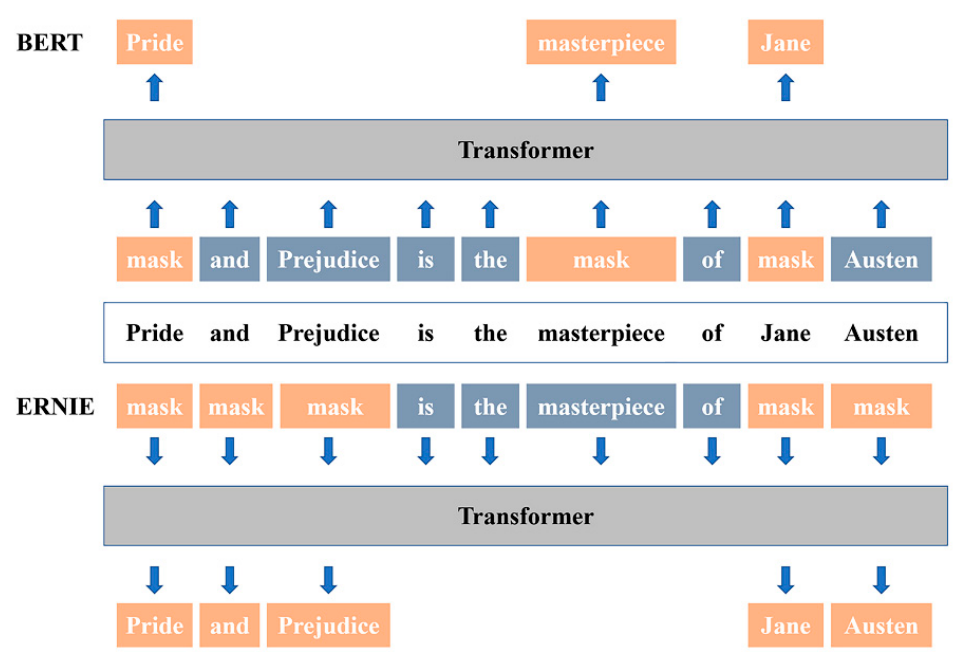
Figure 1. Masking strategy between BERT and ERNIE.